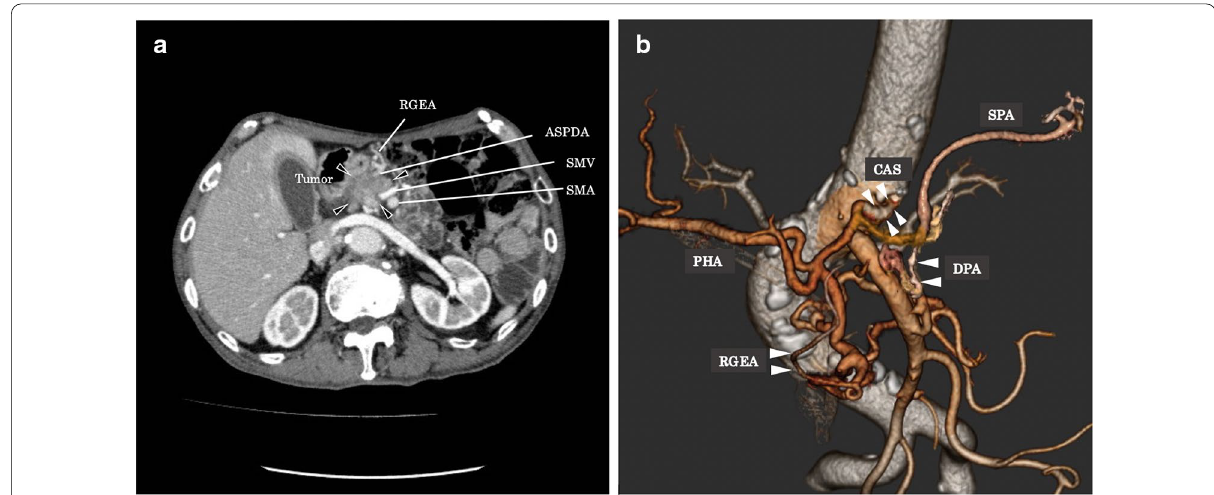
Fig. 1 Axial view and three-dimensional reconstruction using a preoperative abdominal contrast-enhanced computed tomography. a Iso-dense mass (arrowheads) in the pancreatic head with attachment on the anterior superior pancreaticoduodenal artery (ASPDA). b Celiac artery stenosis (CAS) and branch from the superior mesenteric artery (SMA) to the splenic artery (SPA) via the dorsal pancreatic artery (DPA) before